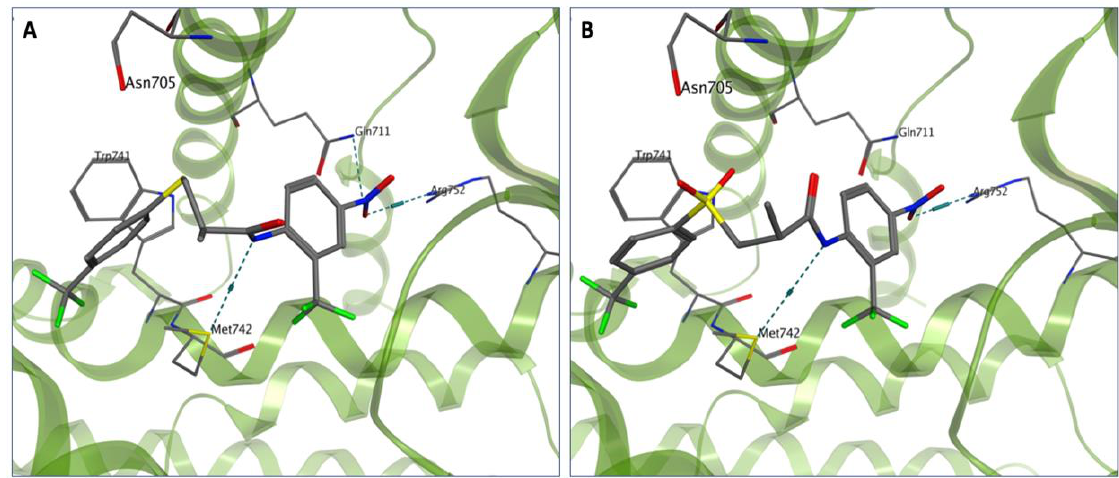
Figure 4. The predicted binding mode of compounds 16 ( A ) and 21 ( B ) within the hAR-LBD showing H-bond interactions (blue dashed line) with Arg 752, Gln 711, Met 742.